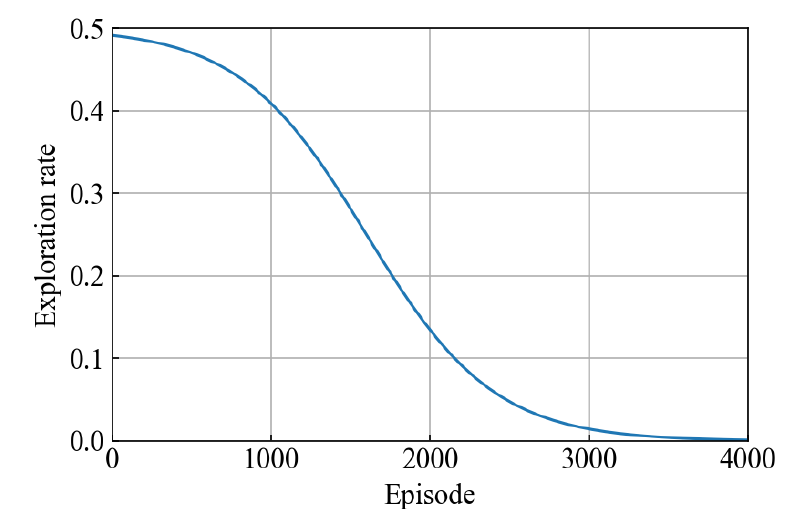
Figure 6. The (cid:101) -greedy exploration function when N E =